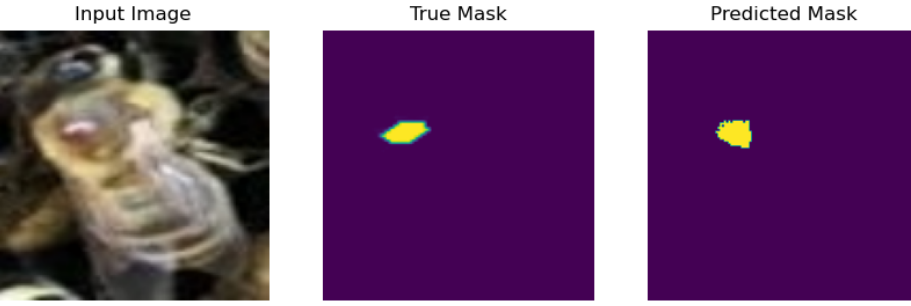
Figure 6. Varroa segmentation by U-NET. The yellow region represents varroa. True Mask is ground- truth segmentation and Predicted Mask is the predicted